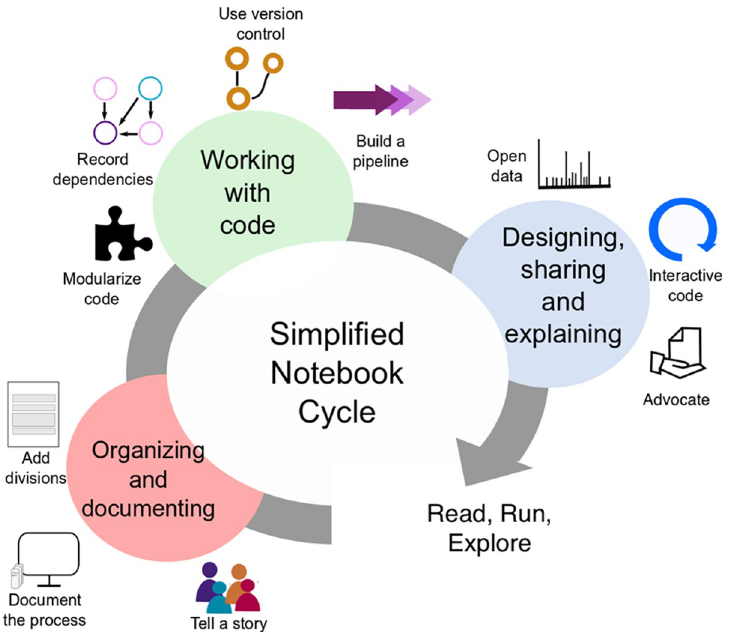
Fig 1. Iterative workflow for applying the 10 simple rules to the creation of Jupyter Notebooks. The cycle describes three overlapping phases of developing a well-documented and functional Jupyter Notebook. First, we organize and document the notebook (Rules 1–3). Second, the code is developed following the rules proposed here about quality standards (Rules 4–7). Finally, the notebook is made available, along with its data (Rule 8), in a manner encouraging public exploration and contribution (Rules